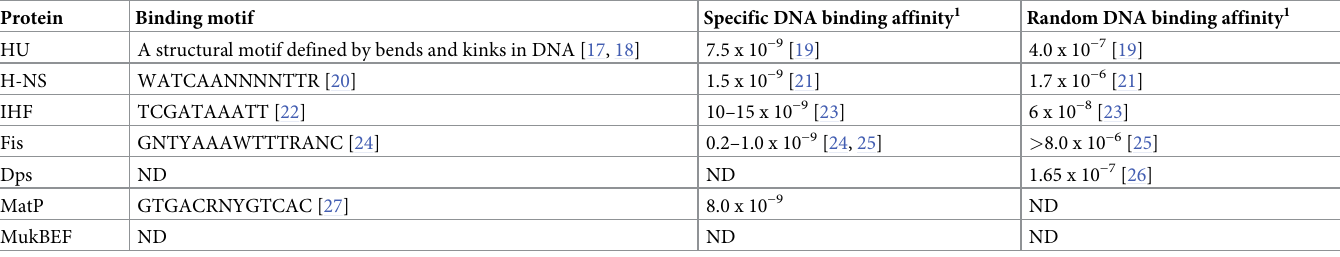
Table 2. DNA binding properties of nucleoid architectural proteins of E . coli .